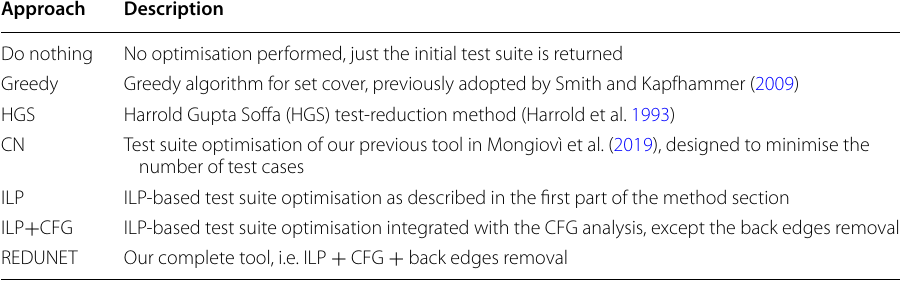
Table 3 Approaches. Description of approaches compared in this experimental analysis Approach Description